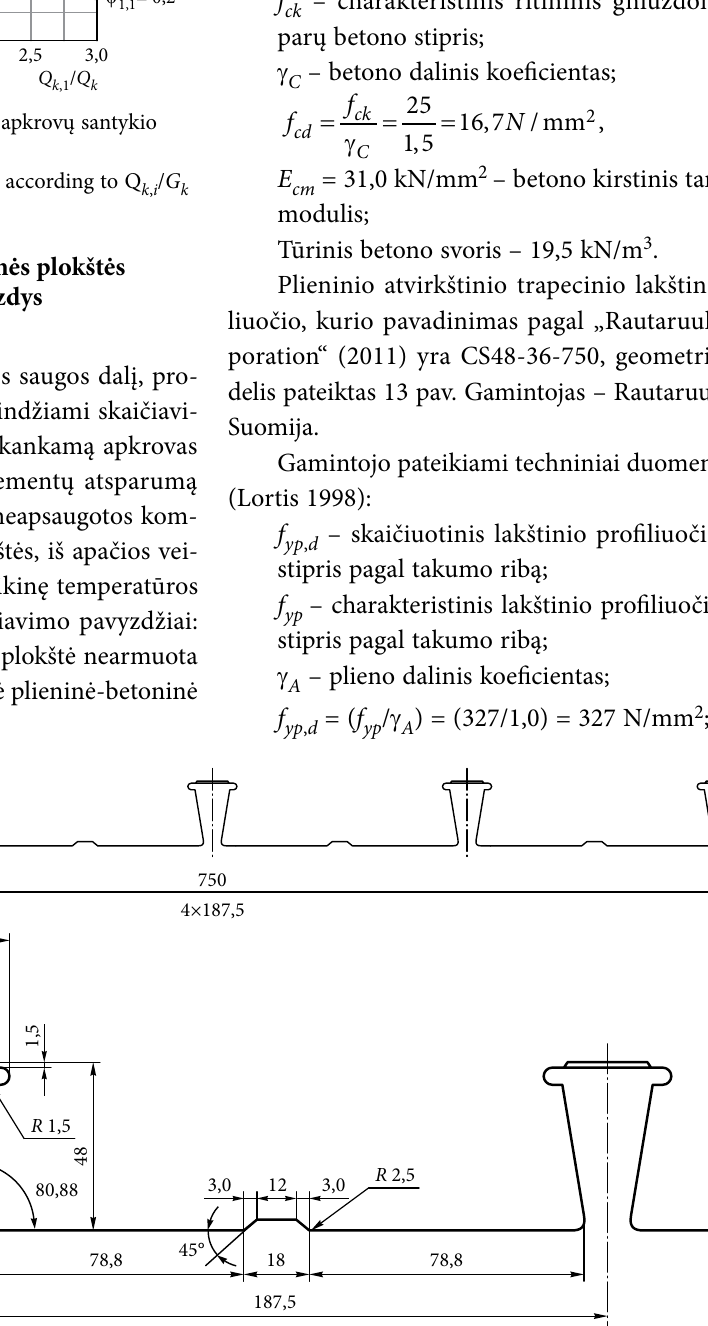
Fig. 12. Correctional coefficient h